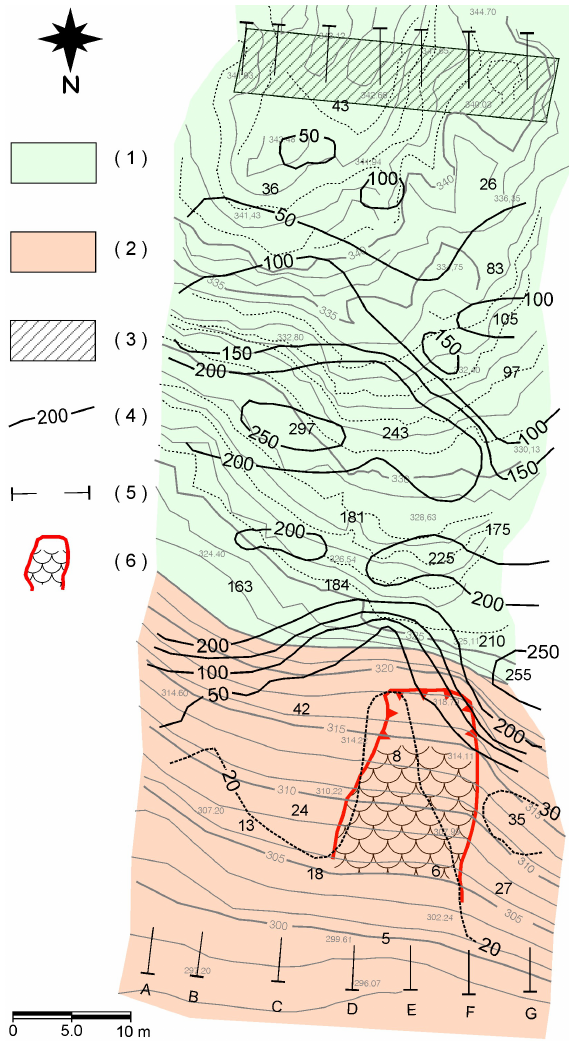
Fig. 10. Iso-energy (total kinetic energies) map of the study area. (1) dolomitic-limestones; (2) pyroclastic deposits; (3) instability zone, containing the rockfall starting points; (4) iso-energy curve and related value in kJ; (5) slope profile used for performing trajec- tory back-analysis with the ROCFALL code; (6) debris-flow land- slide crown.